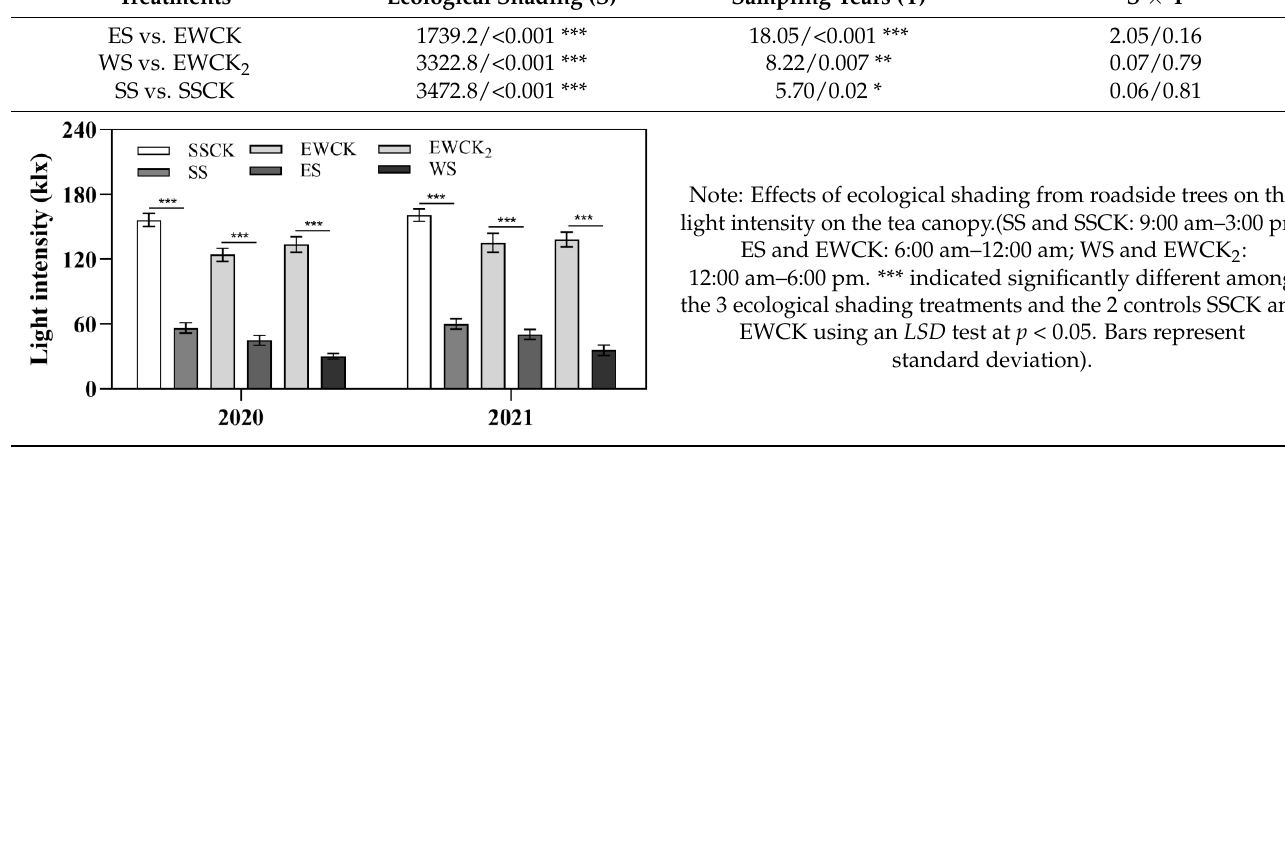
Table A1. Two-way repeated measures ANOVAs of light intensity of the ecological shading treat- ments, and corresponding control (values were F / p , * p < 0.05; ** p < 0.01; *** p < 0.001.). Biology 2022 , 11 , x FOR PEER Treatments Ecological Shading (S) Sampling Years (Y) S × Y ES vs. EWCK 1739.2/<0.001 *** 18.05/<0.001 *** WS vs. EWCK 2 3322.8/<0.001 *** SS vs. SSCK